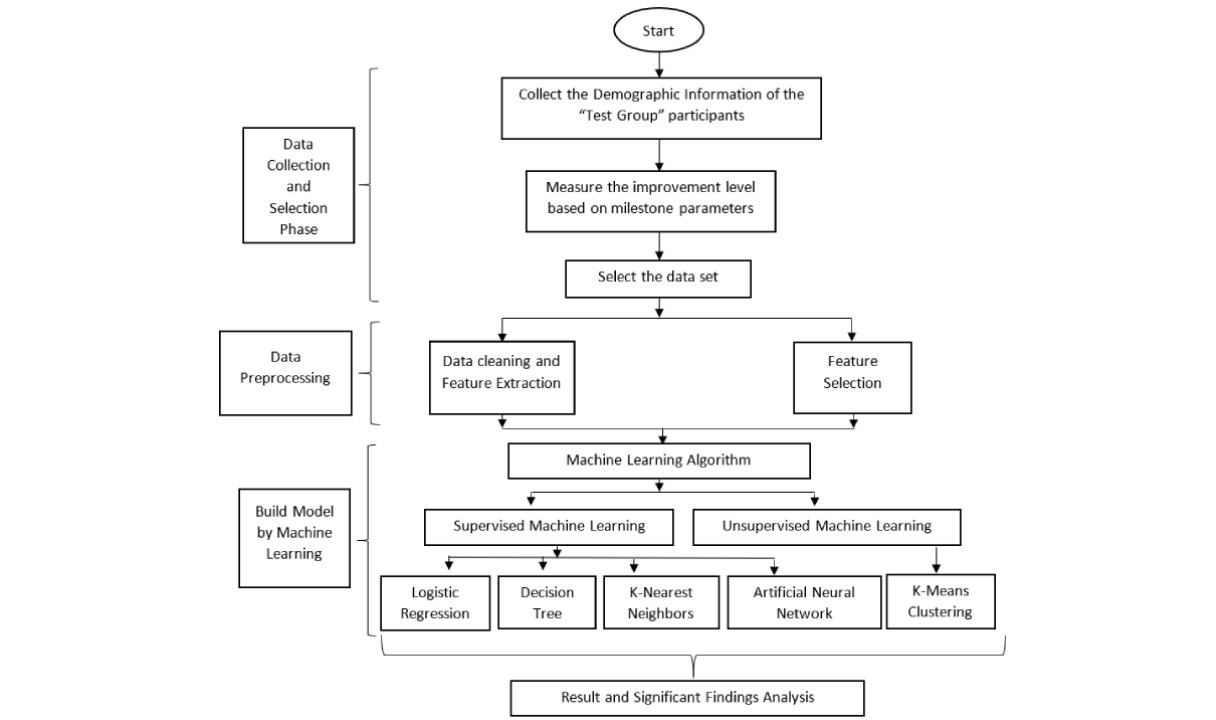
Figure 1. Outline of research